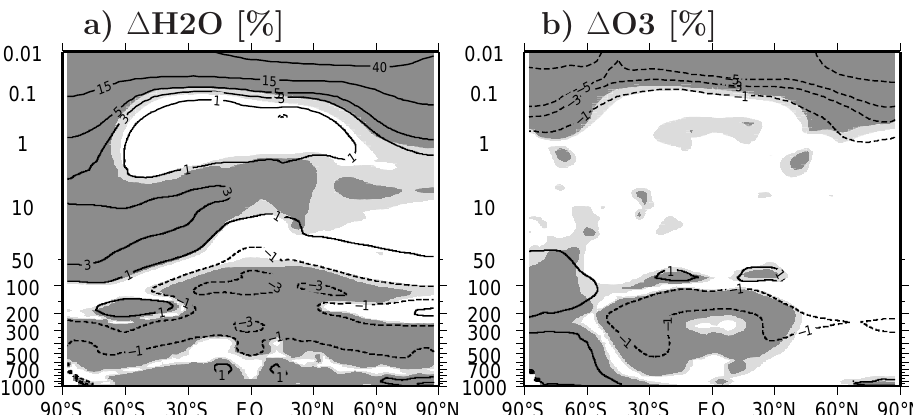
Fig. 8. Same as Fig. 6, but for the relative deviation of simulation coup rad versus coup full (see Table 1). (a) 1 H 2 O [%] (gaseous only), (b) 1 O 3 [%].